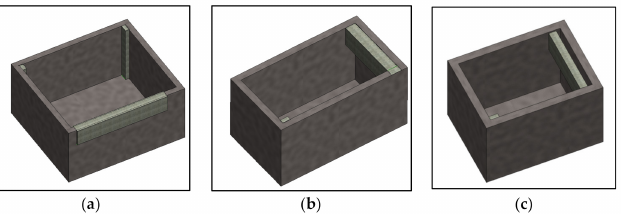
Figure 5. Automatic modeling results of ( a ) Conference_Room2, ( b ) Office_2, and ( c ) Office_6 without ceiling.